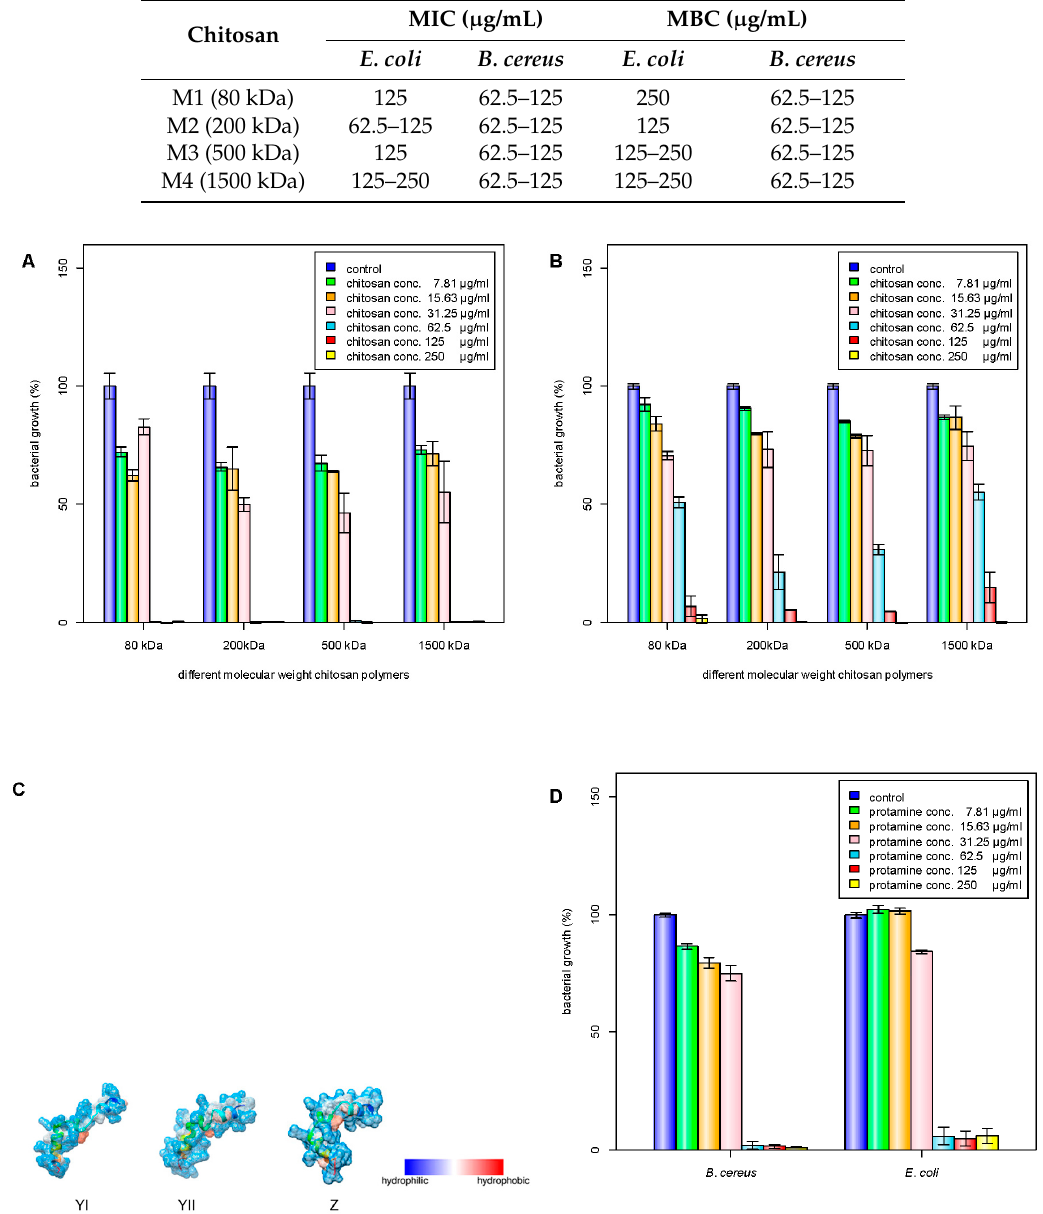
Table 1. Antimicrobial activities of chitosan polymer against Escherichia coli ( E. coli ) and Bacillus cereus ( B. cereus ). MBC: minimum bactericidal concentration; MIC: minimum inhibitory concentration.